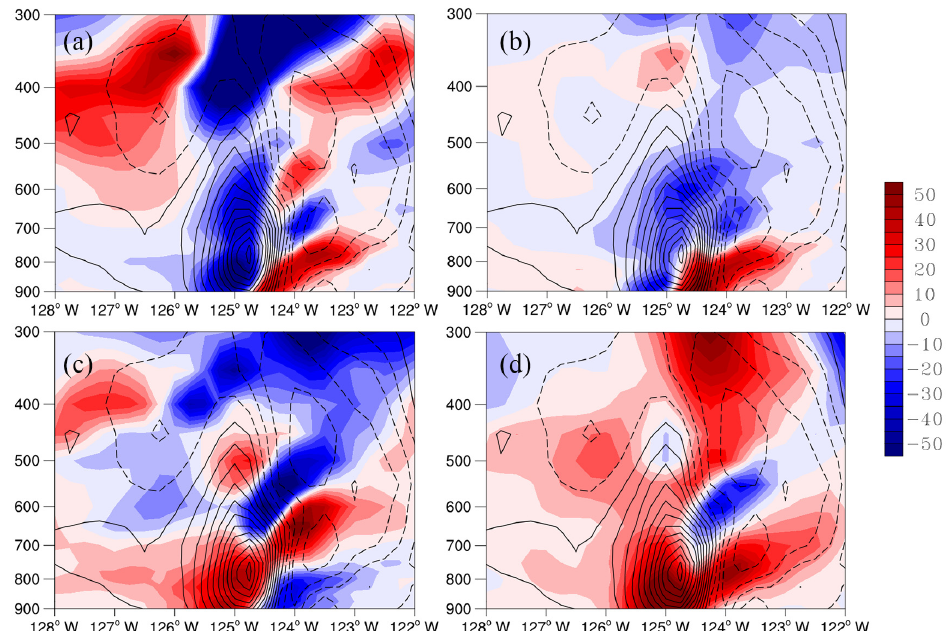
Figure 8. Vertical structures of energetics (shadings; in 10 − 4 m 2 s − 3 ) and mesoscale vertical velocity ( − ω ∼ 2 ; contours; in Pa/s) averaged over the channel 42 ◦ –44 ◦ N on 25 February at 10:00 UTC: ( a ) Γ 0 → 2 , ( b ) Γ 1 → 2 , ( c ) Γ 0 → 2 and ( d ) − b 2 . Solid contours stand for the ascending motion with an interval of